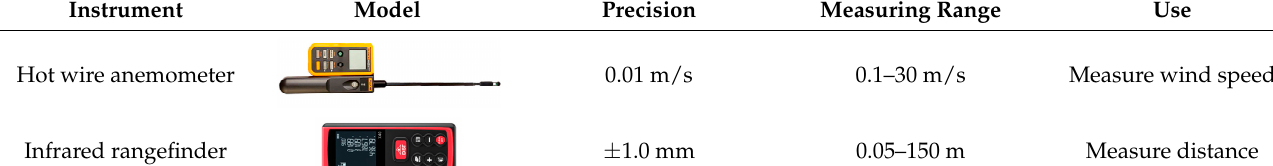
Table 1. The detailed information of the instruments. Table 1. the detailed information of the instruments. Table 1. the detailed information of the instruments. Table 1. the detailed information of the instruments.